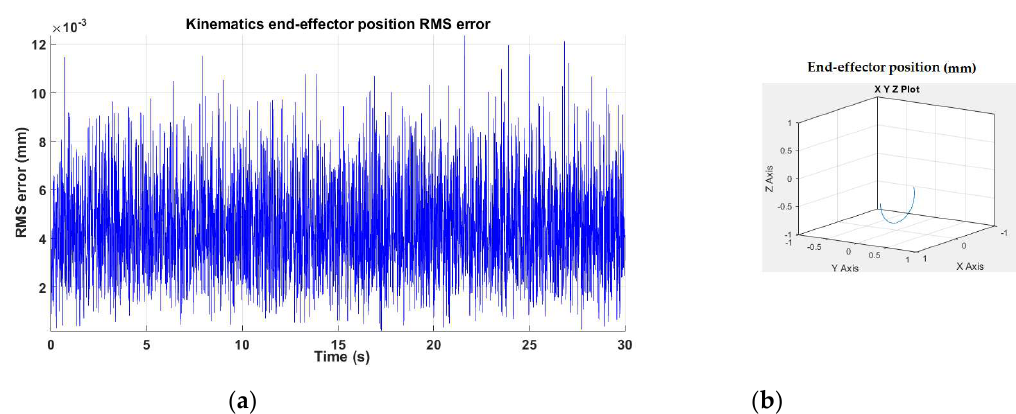
Figure 18. Normal condition: ( a ) kinematics end-effector position root mean square (RMS) error and ( b ) end effector position in the XYZ axis.